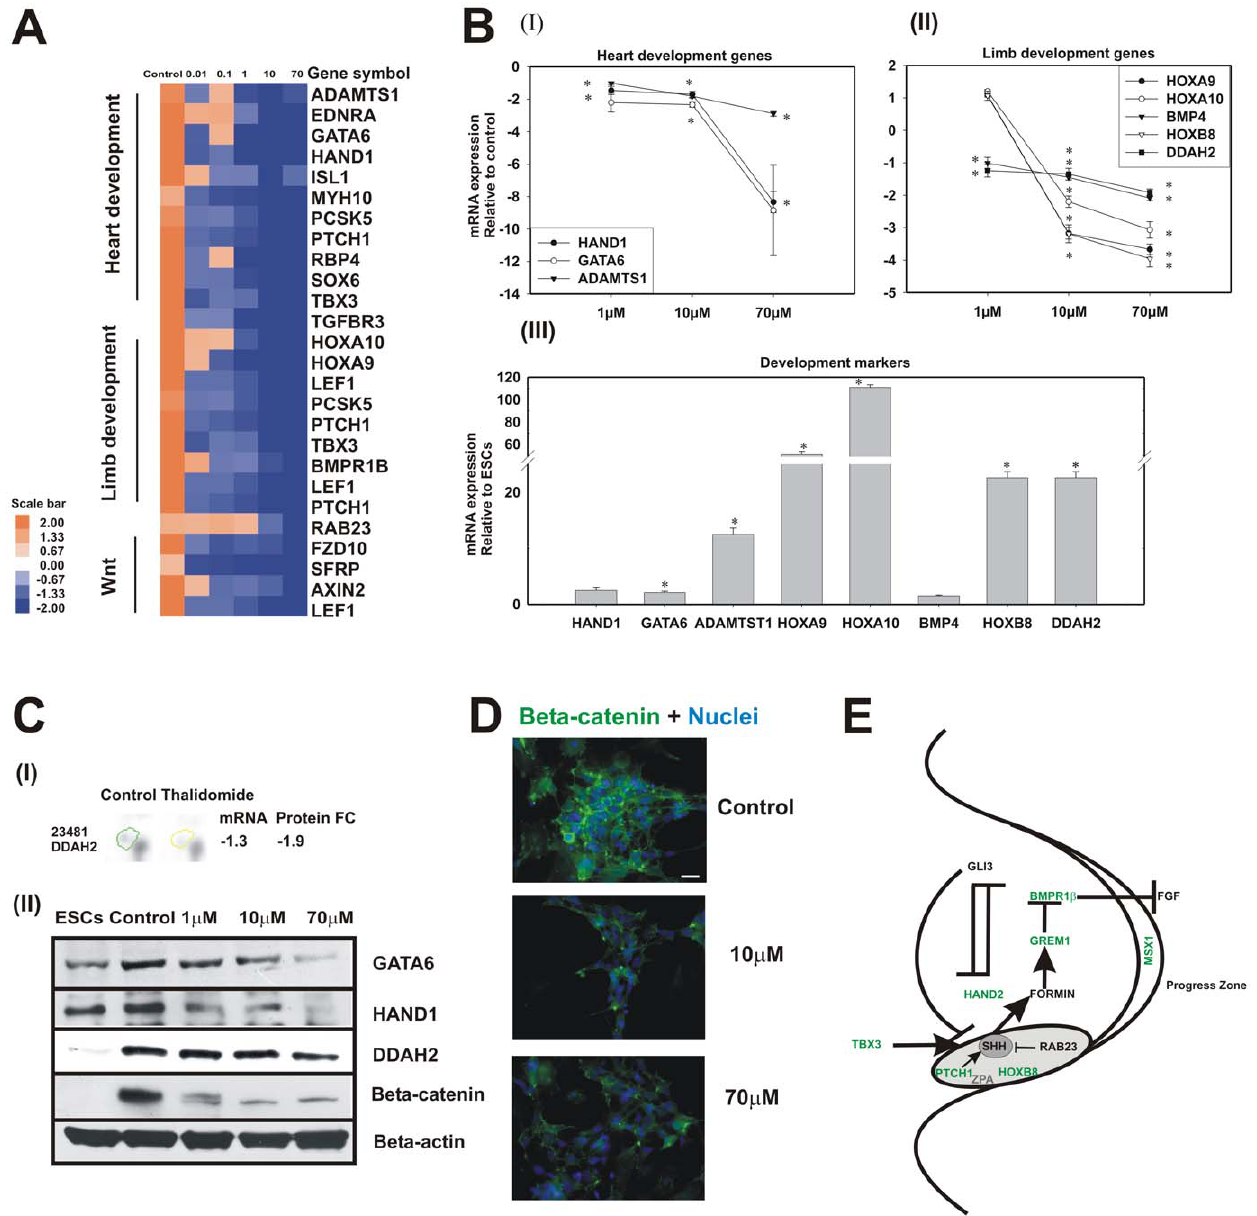
Figure 4. Thalidomide perturbed heart, limb development and WNT signalling associated genes. A , The heat map shows the microarray expression pattern for the selected genes for heart, limb development (from Table S6D, S6F) and WNT signalling (from Table S9). Since multiple genes are involved in various developmental processes few redundant genes are present. The up-regulated genes in control were repressed in a dose dependent manner. B , The representative heart (I), limb development (II) associated genes were analysed using RT-qPCR analysis with an independent experiment. Thalidomide responsive genes were shown in I and II (*p-value # 0.01, thalidomide-treated vs untreated 14-days old EBs) and 14 days old EBs gene expression were shown in (III) *p-value # 0.01, 14 days old EBs vs ESCs . The error bars represents the SEM from 3 technical replicates. C , The mass spectrometry results showed down-regulation of DDAH2 gene (n=3), (p # 0.01). Figure C (I) represents spot analysis of DDAH2, mRNA and protein fold change (FC) values. C (II) The immunoblotting analysis of representative genes for thalidomide treatment. D , The immunoflourescence results shows the localisation of b -catenin and the gradient suppression at 70 m M thalidomide treatment. The scale bar represents 20 m m. E , The figure representing limb bud patterning was adapted from [40] and modified. The figure shows the molecular markers that SHH and ZPA (essential for limb development) were affected by thalidomide treatments. The green colour coded genes are more than 2 1.8 fold down-regulated. doi:10.1371/journal.pone.0044228.g004 developmental conditions using hESCs suitably recapitulate the Canonical embryonic limb bud development in vertebrates disturbances in heart and limb development observed in in vivo proceeds along the proximal to distal (P–D), A–P and dorsal to animal studies [11,15,39]. ventral (D–V) axes [40]. P–D limb development is regulated by apical ectodermal ridge (AER) and FGF signalling [40]. The A–P